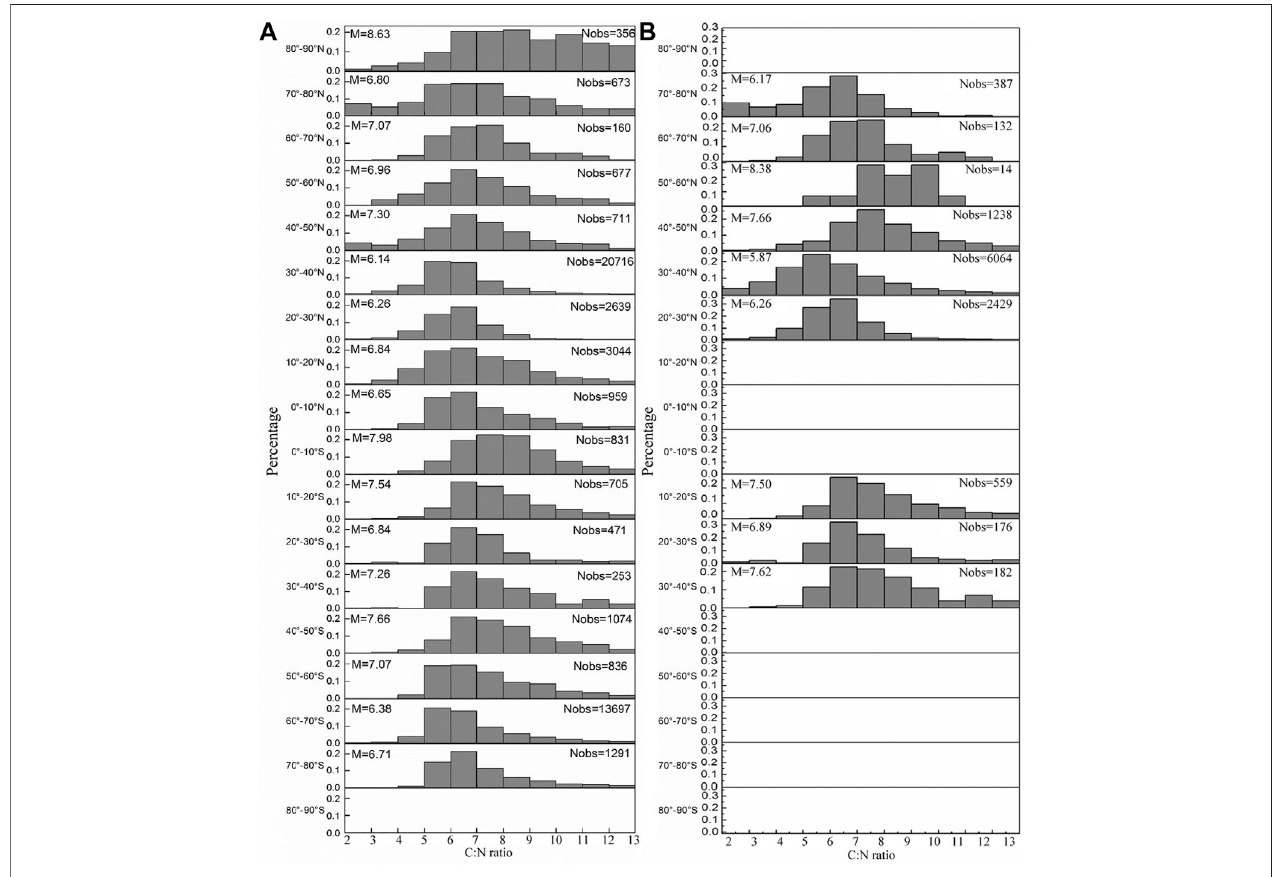
FIGURE 3 | Latitudinal patterns of the global C-to-N ratio (upper 300 m). (A) Only including the region affected by ocean currents. (B) the region without ocean currents. The blank indicates no data. M is the median ratio.